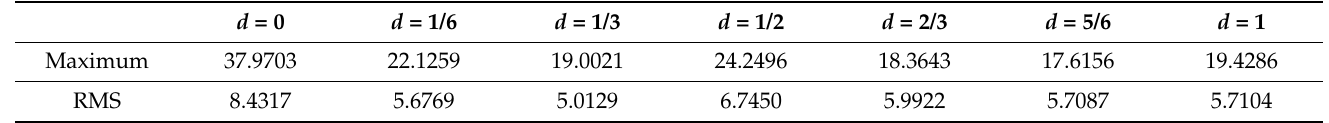
Table 6. Characterization of the acceleration spectra in the second ground profile